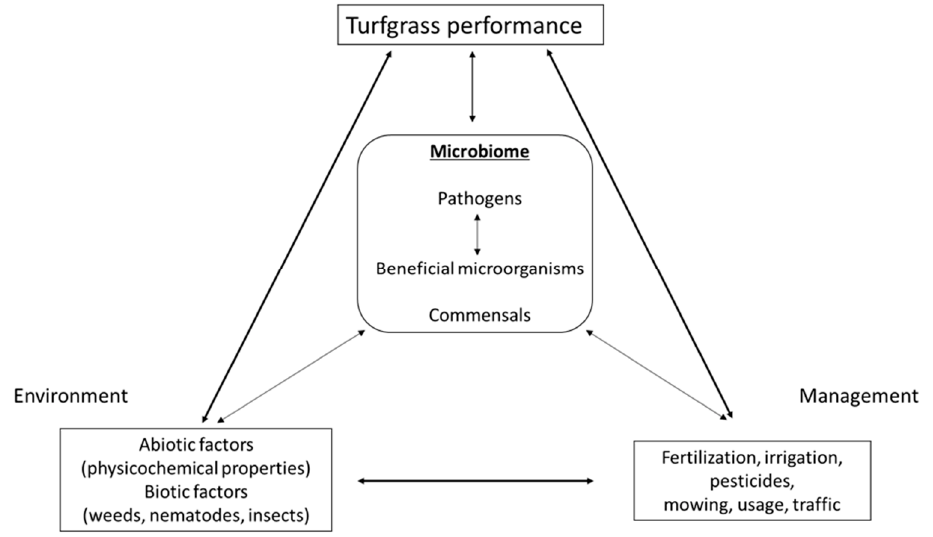
Figure 3. Interconnectedness of turfgrass management, environmental conditions, microbiome, and turfgrass performance. Connectors in bold indicate very strong support in the literature, whereas faint connectors indicate a critical lack of knowledge.